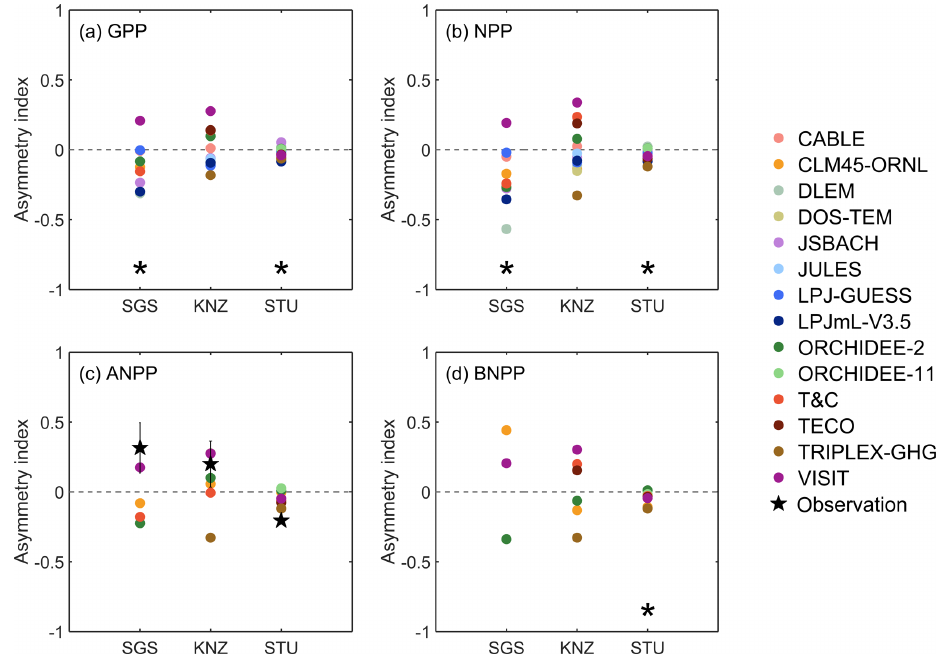
Figure 2. Asymmetry responses of inter-annual GPP (a) , NPP (b) , ANPP (c) and BNPP (d) to precipitation in ambient simulations at the three sites SGS, KNZ and STU. The asymmetry index was calculated as the difference between the relative productivity pulses ( R p ) and declines ( R d ) in wet years and dry years (see Eqs. 1–3). Black pentagrams in (c) represent asymmetry indices from observations. The corresponding black error bars represent the observed uncertainty ranges using Eqs. (4)–(6). A black asterisk at the bottom of a panel indicates a significant asymmetry response of the model ensemble at a 0.1 significance level by a non-parametric statistical hypothesis test (Wilcoxon signed-rank